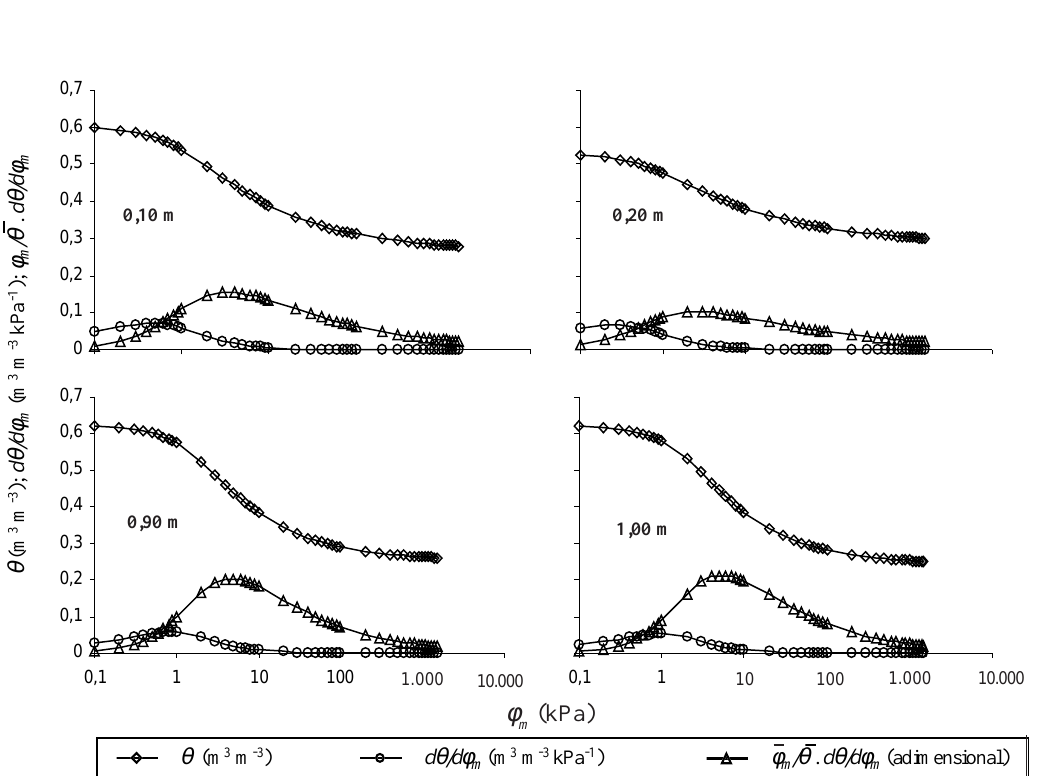
Figura 3. Curva de retenção da água no solo, d qqqqq /d fffff 0,90 e 1,00